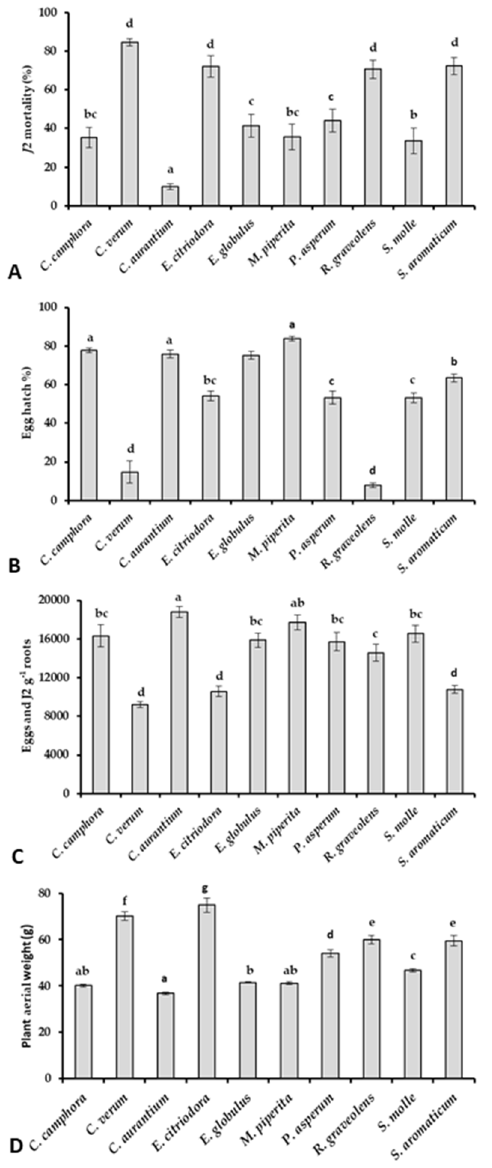
Figure 3. EOs’ aggregated effects on J2 mortality ( A ), egg hatchability ( B ), M. incognita multiplication on roots ( C ) and tomato growth ( D ). Bars marked with the same letters are not significantly different according to Least Significant Difference Test ( p ≤ 0.05).